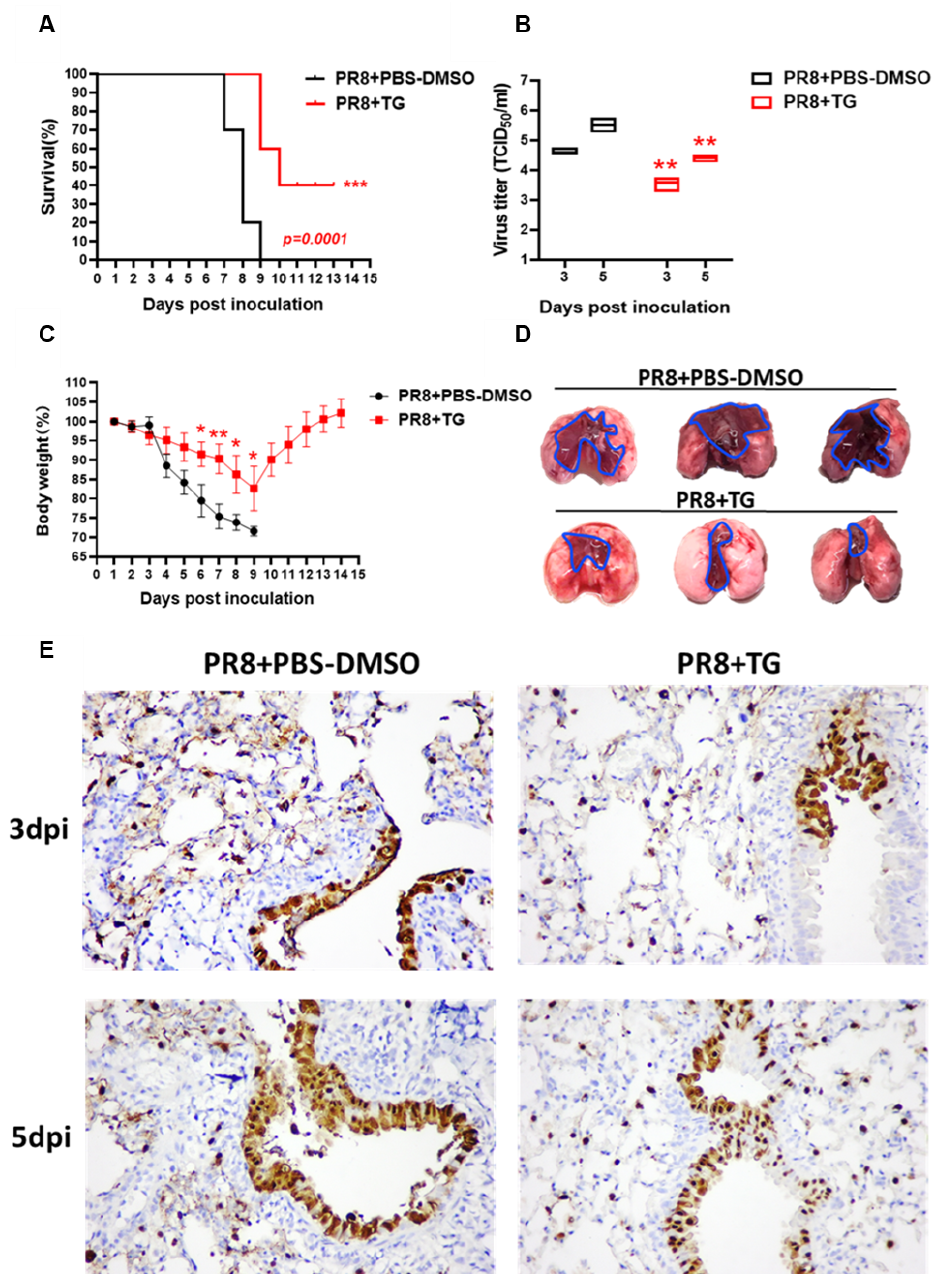
Figure 6. TG in mice confers protection against lethal PR8 H1N1 virus challenge. ( A ) Survival of mice post-infection treated each day with TG or PBS-DMSO control ( n = 10 in each group). Kaplan-Meier survival curves are compared using the log-rank (Mantel-Cox) analysis. ( B ) Viral titres of lungs from mice treated with TG or PBS-DMSO at 3dpi and 5dpi was determined by TCID 50 assays ( n = 3 in each group). ( C ) Mean body weight changes post-infection was determined by daily monitoring ( n = 10 in each group). ( D ) At 5 dpi, entire lungs of TG treated mice displayed much less extensive gross pathology than those of control lungs. Blue outline demarcates boundary between apparent normal and consolidated abnormal tissues. ( E ) Representative microscopic lung fields, (40-time magnification), derived from similar anatomical sites taken at 3 and 5 dpi, showed that TG treatment resulted in less di ff used distribution of viral NP protein (less brown staining), and more frequent localisation of NP than those in corresponding PBS-DMSO controls. Each mouse was infected at 1 × 10 2 TCID 50 of PR8 virus. ** p < 0.01, *** p <